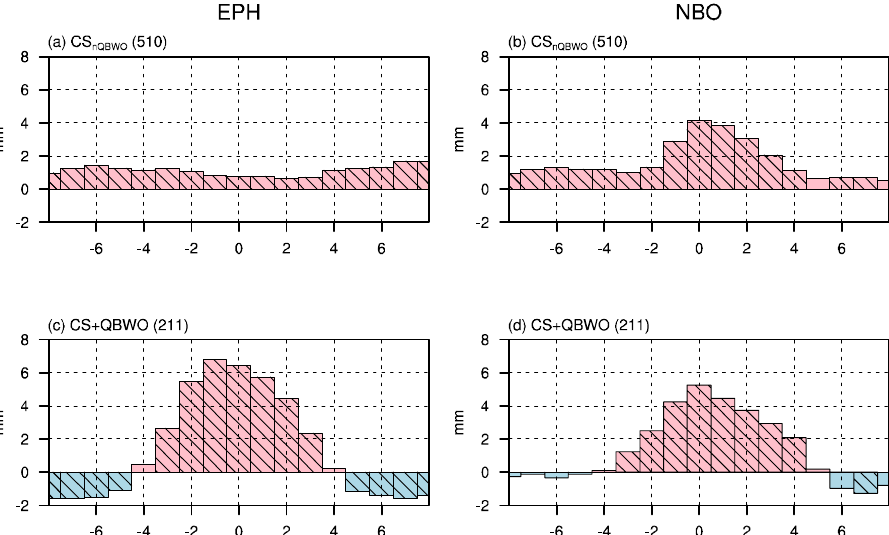
Figure 7. Composite daily evolution of area − mean precipitation over the EPH (10 ◦ –20 ◦ N, 120 ◦ –135 ◦ E; left panel) and over the NBO (5 ◦ –12.5 ◦ N, 110 ◦ –120 ◦ E; right panel) during cold surge days ( a , b ) without and ( c , d ) with the QBWO, respectively. Number in left title indicates the composite days. Values exceeding the 95% confidence levels based on the two-tailed Student’s t -test are shown as oblique lines.